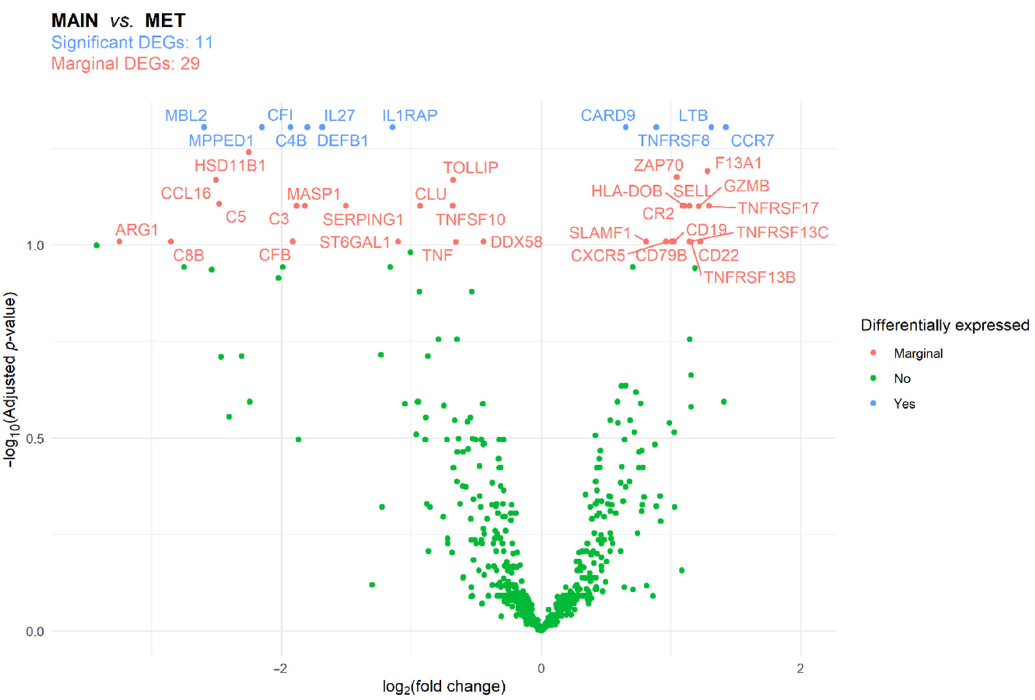
Figure 6. Differentially expressed genes (DEGs) between the main tumor mass (MAIN) and liver metastasis (MET) samples of colorectal cancer patients. The false discovery rate method was used for p ‐ value adjustment.